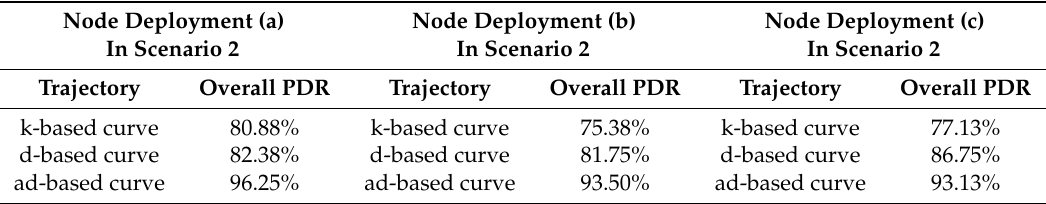
Figure 14. The residual energy of the network in Scenario 3.